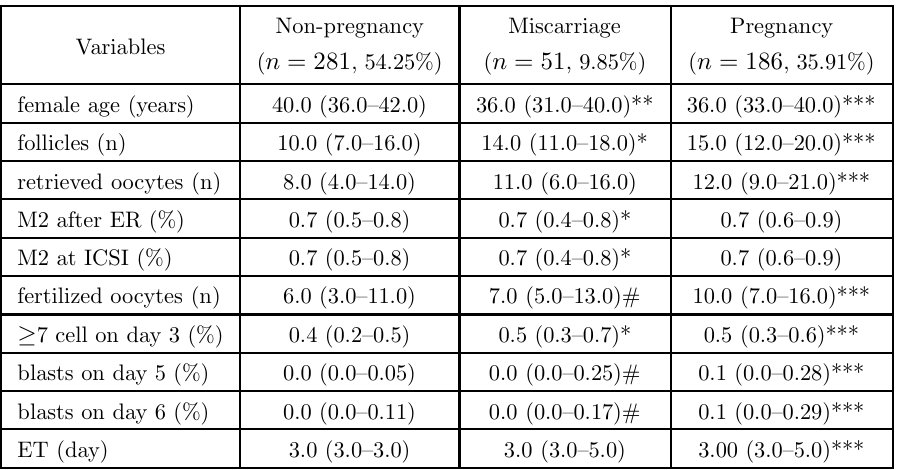
Table 1. Differences between patients with non-pregnancy, miscarriage, and pregnancy. Comparisons vs. non-pregnancy: p < 0.05 * , p < 0.01 ** , p < 0.001 *** , comparisons vs. pregnancy: p < 0.05 # , p < 0.01 ## , p < 0.001 ### . Results presented as median, and upper and lower quartile Non-pregnancy Miscarriage Pregnancy Variables ( n = 281 , 54.25%) ( n = 51 , 9.85%) ( n = 186 , 35.91%) female age (years) 40.0